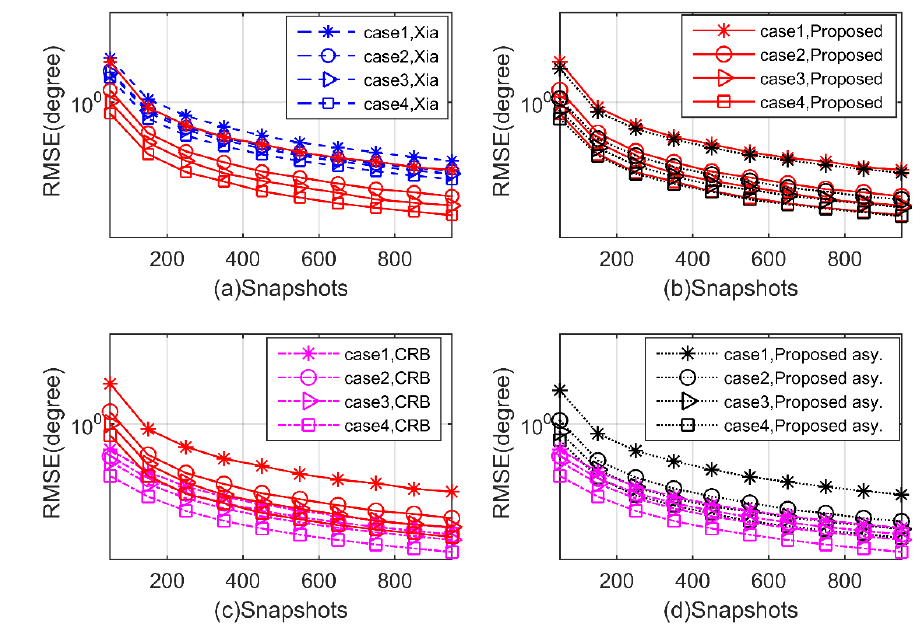
Figure 8. RMSE of 2D-DOD for mixed signals versus snapshots ( a–d